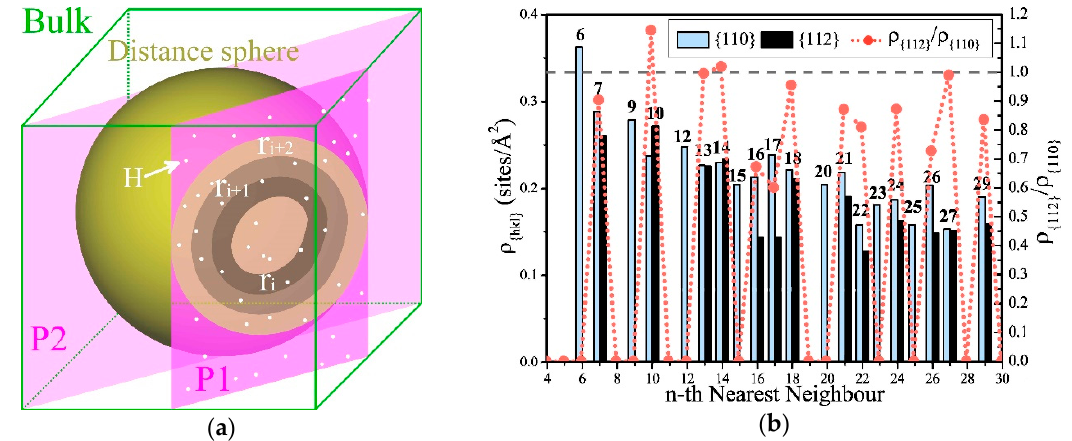
Figure 7. Statistics of the densities of the sites on nth nearest neighbors, which can be occupied by hydrogen atoms on di ff erent slip planes in α -Fe. ( a ) The sketch map of the sites can be occupied by hydrogen atoms on the section of (hkl) planes and the spherical shells can be determined by the positions at the same distance from the reference site Z. The positions are distributed on the concentric spherical shells determined by the distances from Z, and those positions with the same distance from Z are distributed on the same spherical shell. Using one of the {hkl} planes to intersect a certain shell, the hydrogen atoms shared by the shell and the plane determine the local c H on this plane. A set of parallel planes intersects this spherical shell, and the e ff ect on the slip depends on the averaged concentration of this set of crystal planes. ( b ) The Tet-site densities ρ {110} and ρ {112} on the {110} and {112} planes at the nth NN. They are greater than 0 at many NN, and generally ρ {110} > ρ {112}. ρ {112} is the largest at 10NN and 7NN, and is significantly larger than ρ {110} at